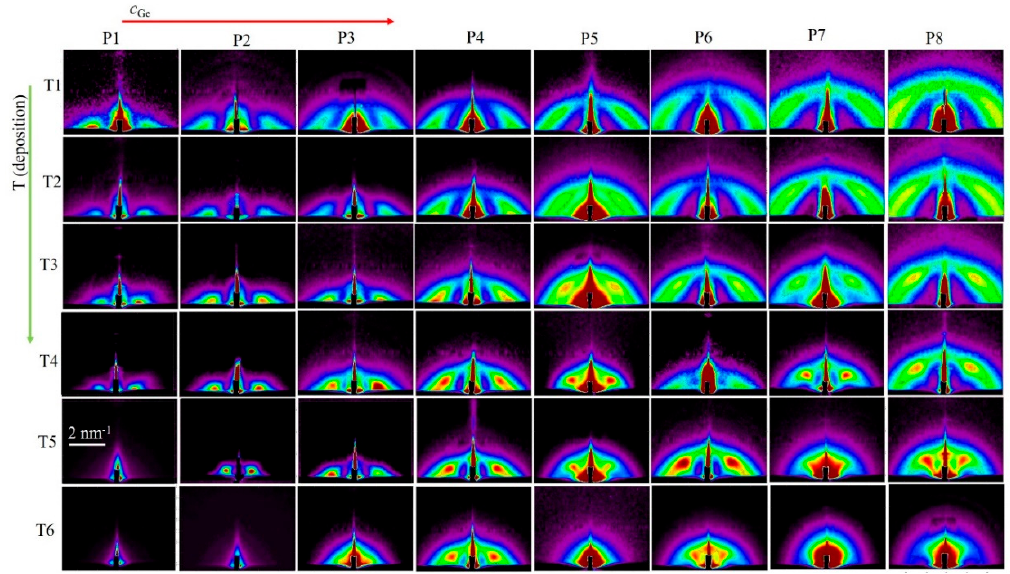
Figure 2. GISAXS maps of all investigated films. An increase in Ge sputtering power (index P), which determines Ge concentration in the film, and deposition temperatures (index T) are indicated at the top and at the left side of the figure, respectively. Numerical values for parameters are given in Table 1.